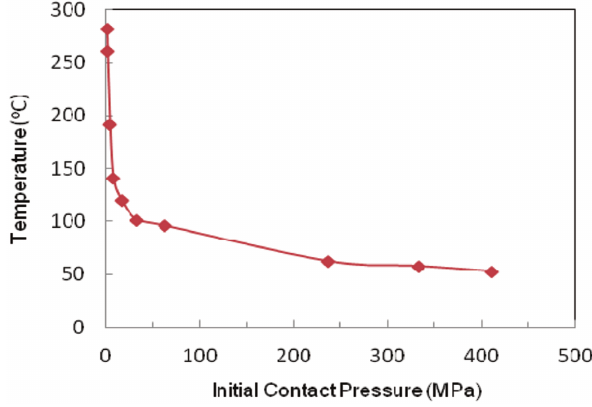
Figure 3: Effect of initial contact pressure on the billet holding temperature.